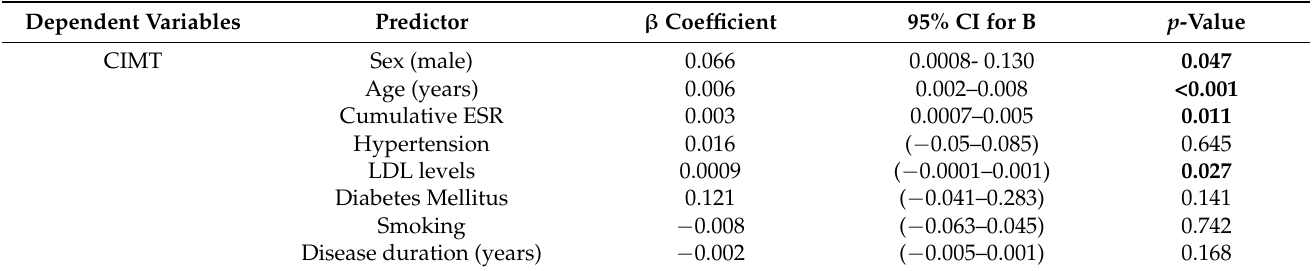
Table 3. Multivariate linear regression model with the sample of